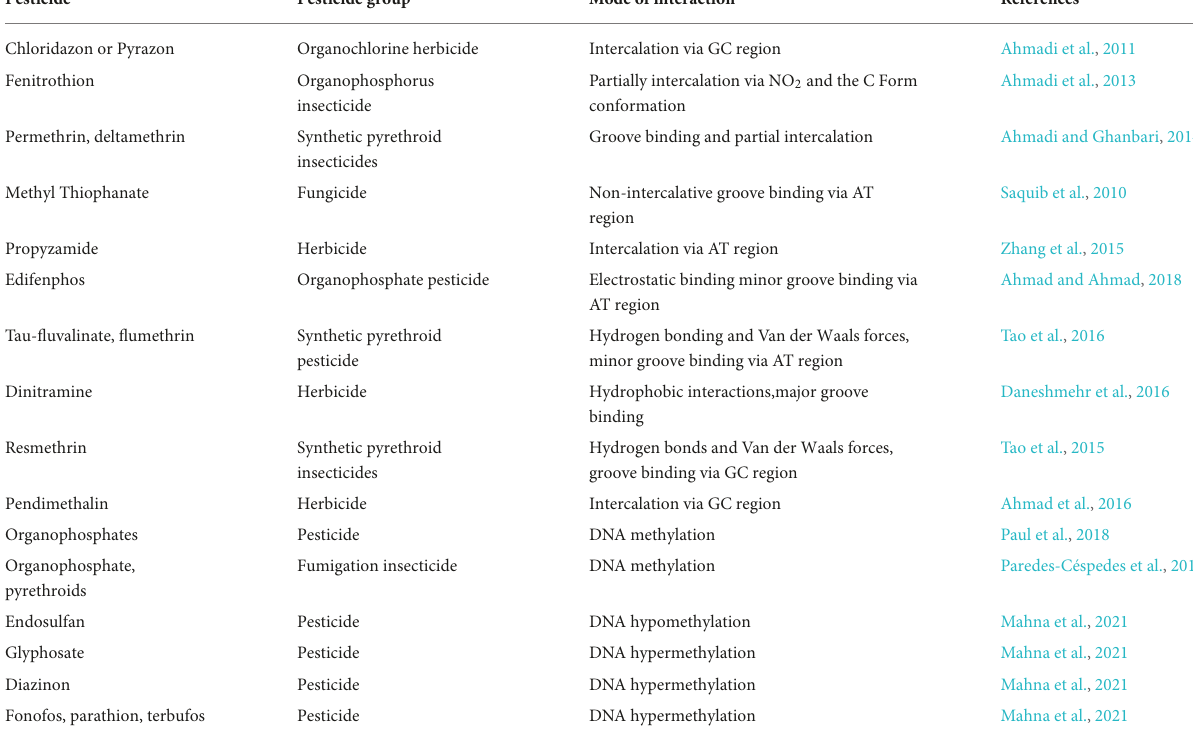
TABLE 5 Mode of interaction of various pesticides with